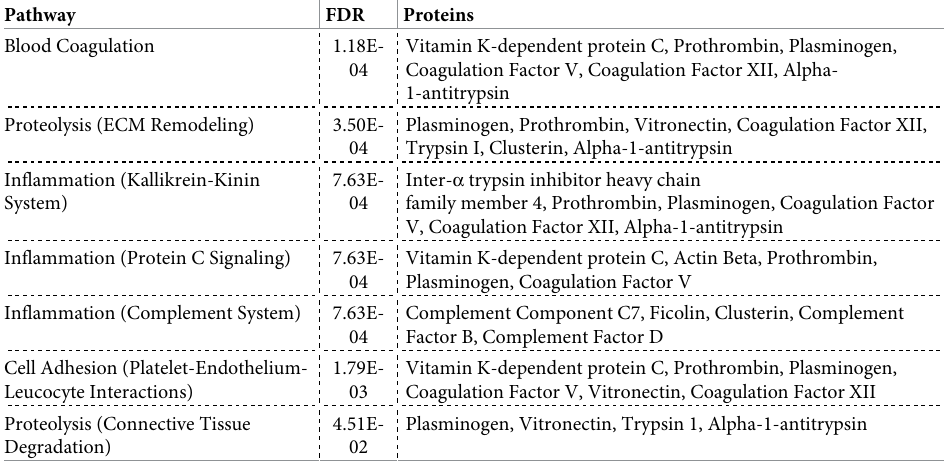
Table 5. Biological pathways enriched by differentially abundant proteins at 6 months.